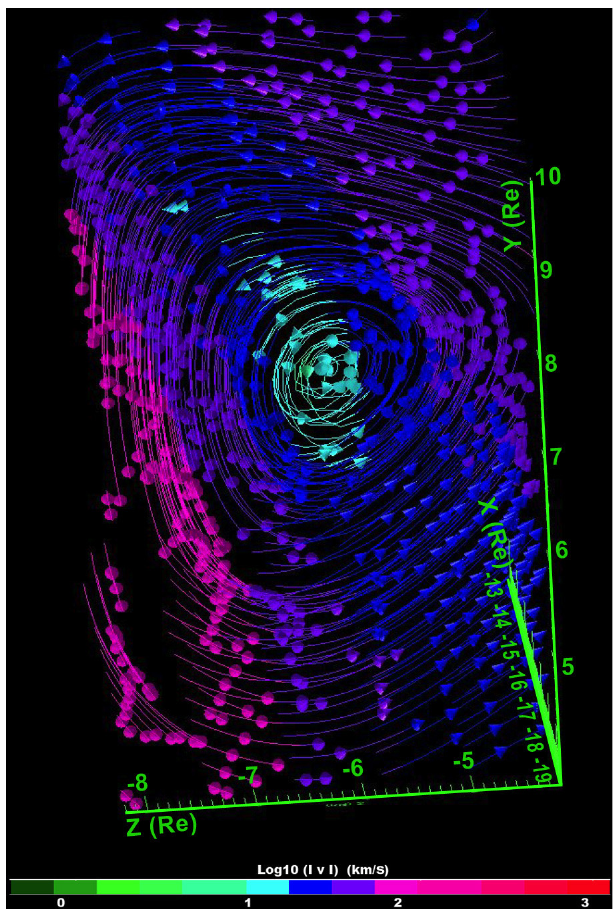
Fig. 5. Inner dusk vortex rotating counterclockwise with its axis closely aligned with the x direction (pattern